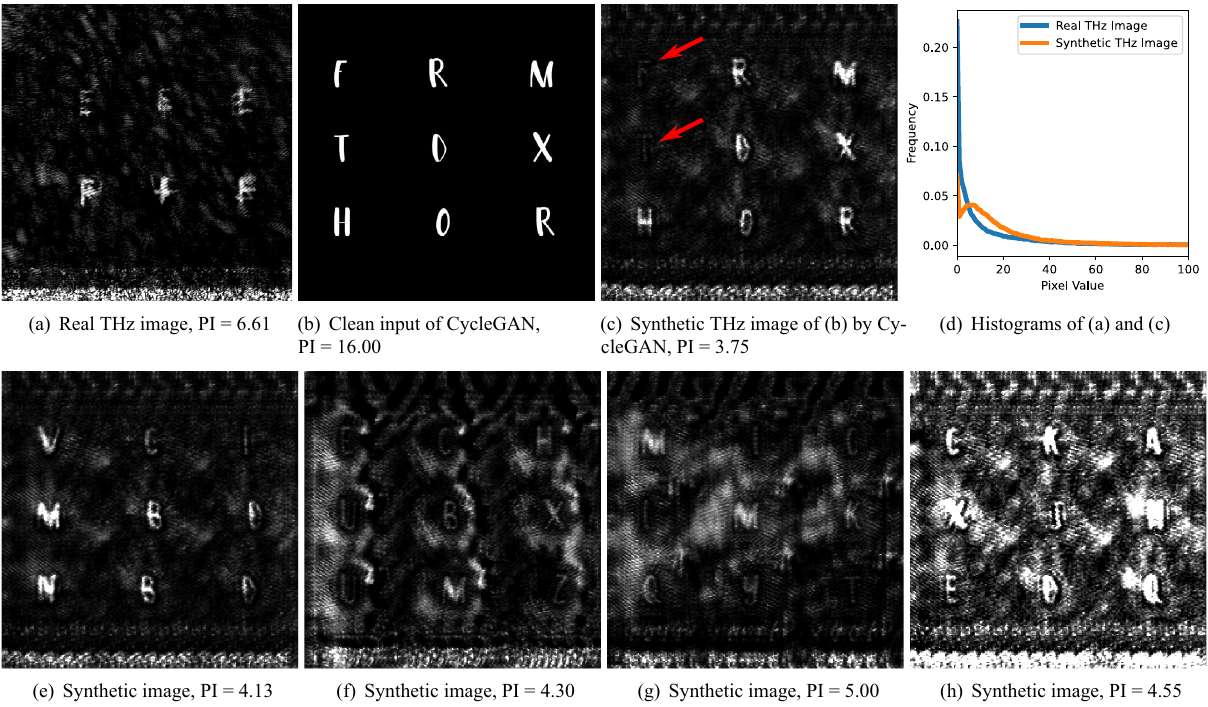
Figure 5. An exemplary real THz image and five exemplary synthetic THz images generated by CycleGAN along with the clean synthetic image. The characters indicated by the arrows in ( c ) are not fully visible. The perceptual index (PI) for each synthetic image is displayed in the corresponding subcaption.